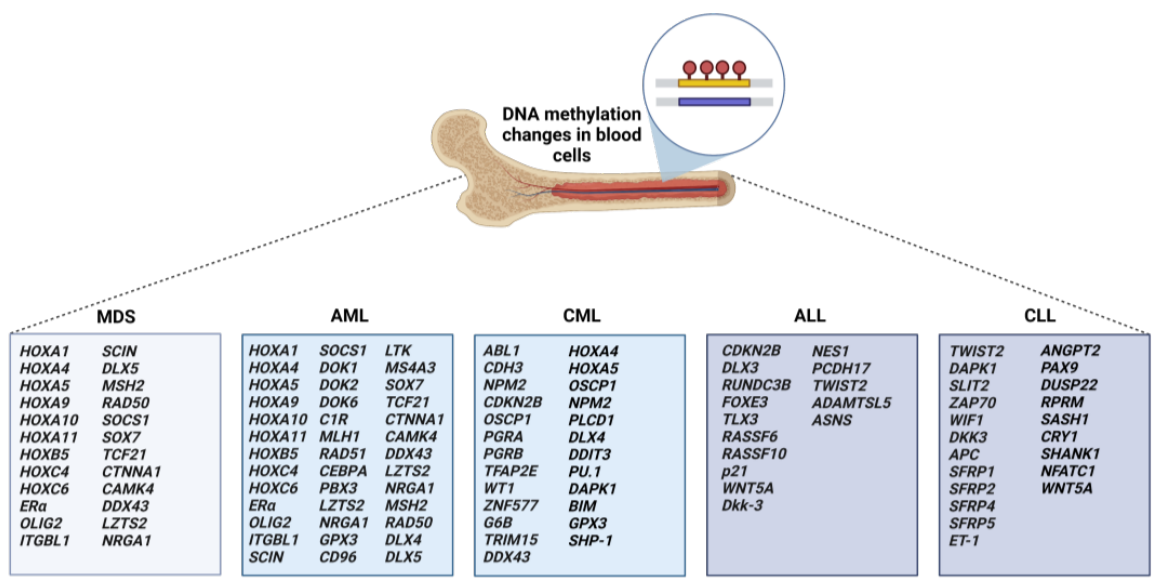
Figure 1. Methylation-affected genes associated with leukemias and myelodysplastic syndromes. DNA methylation plays a key role in the initiation and progression of hematological malignancies. DNMTs catalyze transferring of the methyl group (a red circle) to the 5-carbon position of cytosine within CpG dinucleotides in DNA sequence (each strand of double-stranded DNA is marked by dif- ferent colors, yellow and blue), leading to the formation of 5-methyl-cytosine. Abnormal methylation patterns in bone marrow cells may predict responsiveness to the treatment. A panel of aberrantly methylated genes shown to have diagnostic and prognostic value. Targeting the hypermethylated promoters of tumor suppressor genes might represent a perspective trend for hypomethylating drug therapy alone or in combination. Abbreviation: DNMTs, DNA